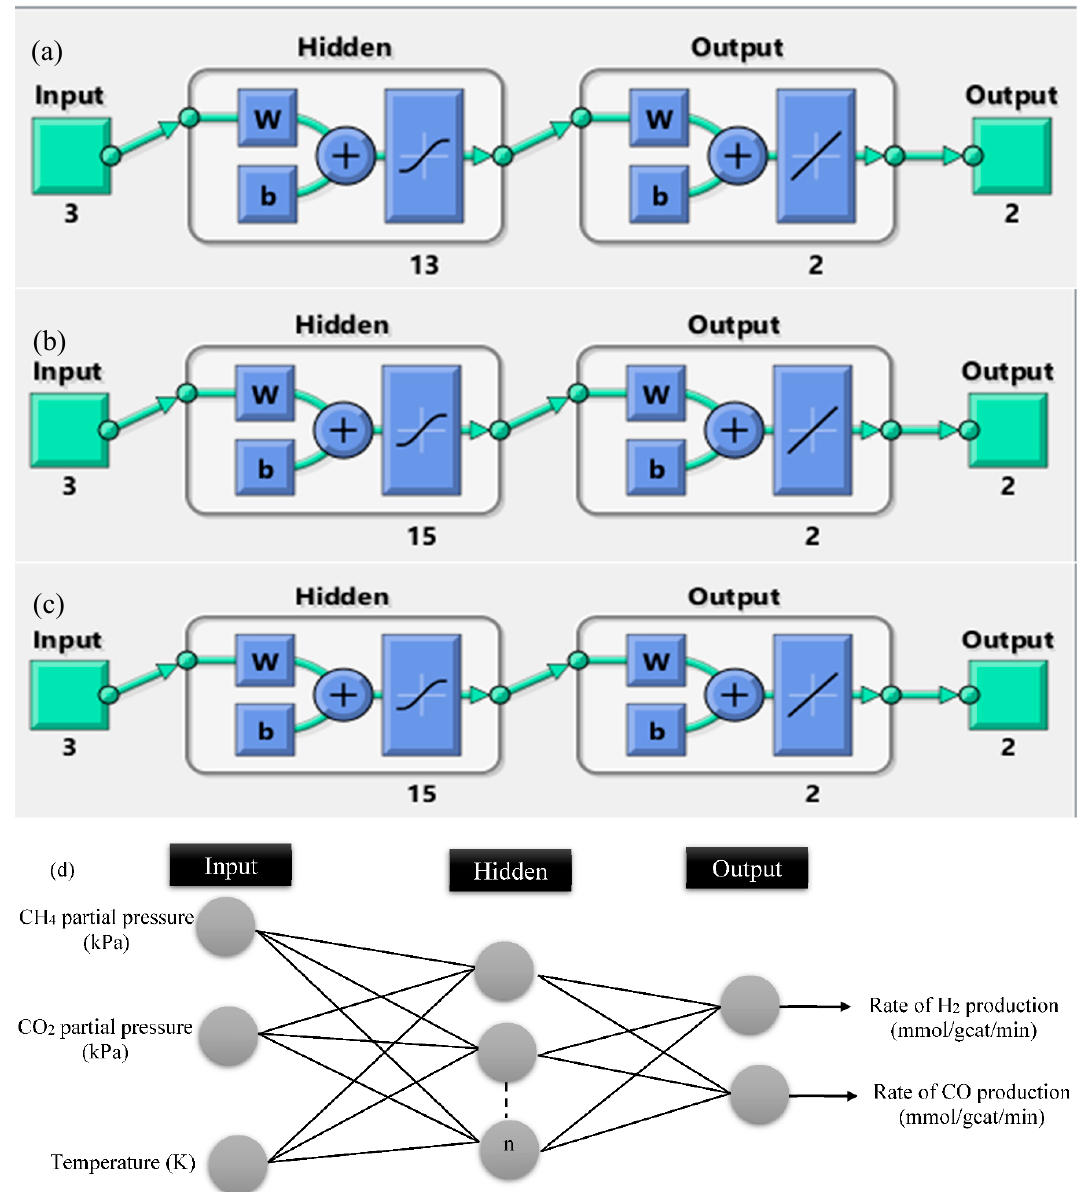
Figure 10. The Network architecture for the ANN modeling used. ( a ) Feed forward multi-layer perceptron architecture for prediction of CO-H 2 production; ( b ) Network configuration using the Leven–Marquardt training algorithm; ( c ) Network configuration using the Bayesian regularization training algorithm; ( d ) Network configuration using the scaled conjugate gradient training algorithm.